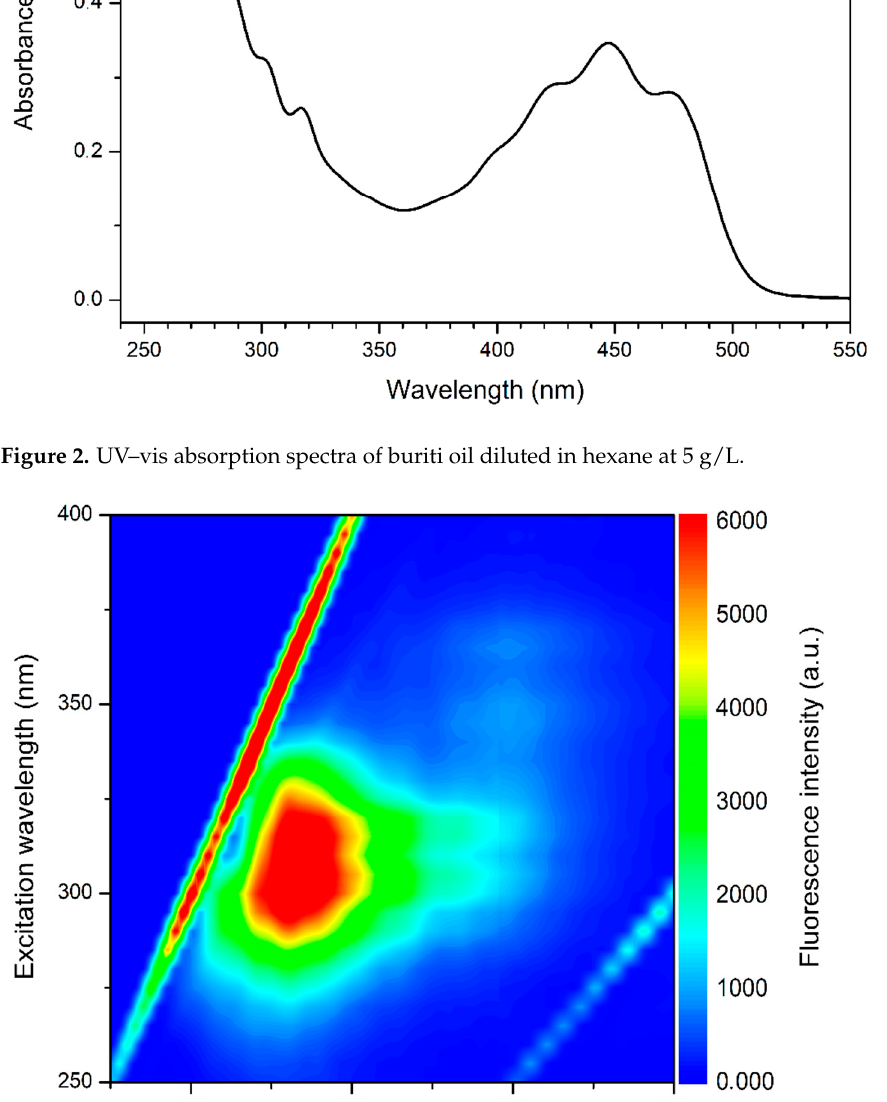
Figure 4. Electric conductivity versus time determined by the Rancimat method for buriti oil.